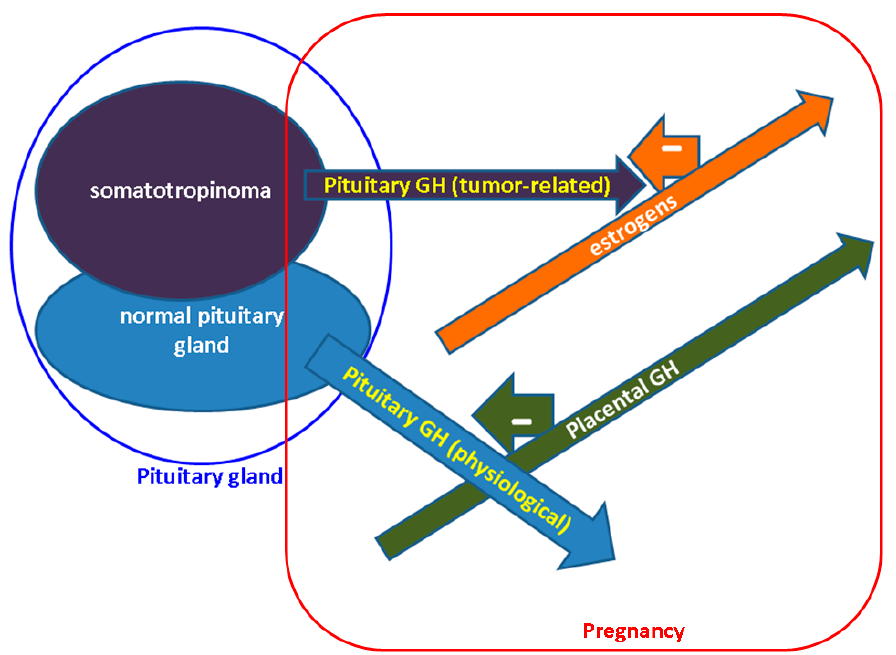
Figure 1. GH amid physiological and acromegalic pregnancy. In non-acromegalic pregnancy pituitary GH is inhibited by the increasing placental GH which takes control of IGF1 levels. In acromeglaic pregnancy, somatotropinoma continues to produce GH, but its actions are antagonized due to estrogen-induced blockade. Abbreviations: GH = Growth Hormone (see references [30–43]).